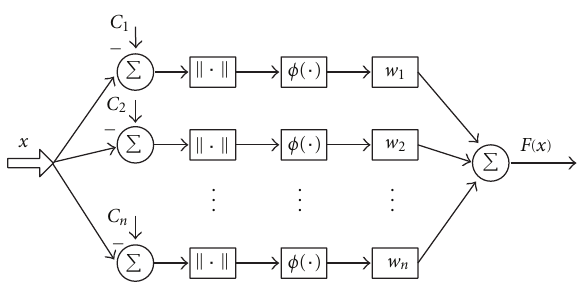
Figure 1: Blockdiagram representation of radial basis function net- work (RBFNs) with input x ∈ R m and output F ( x